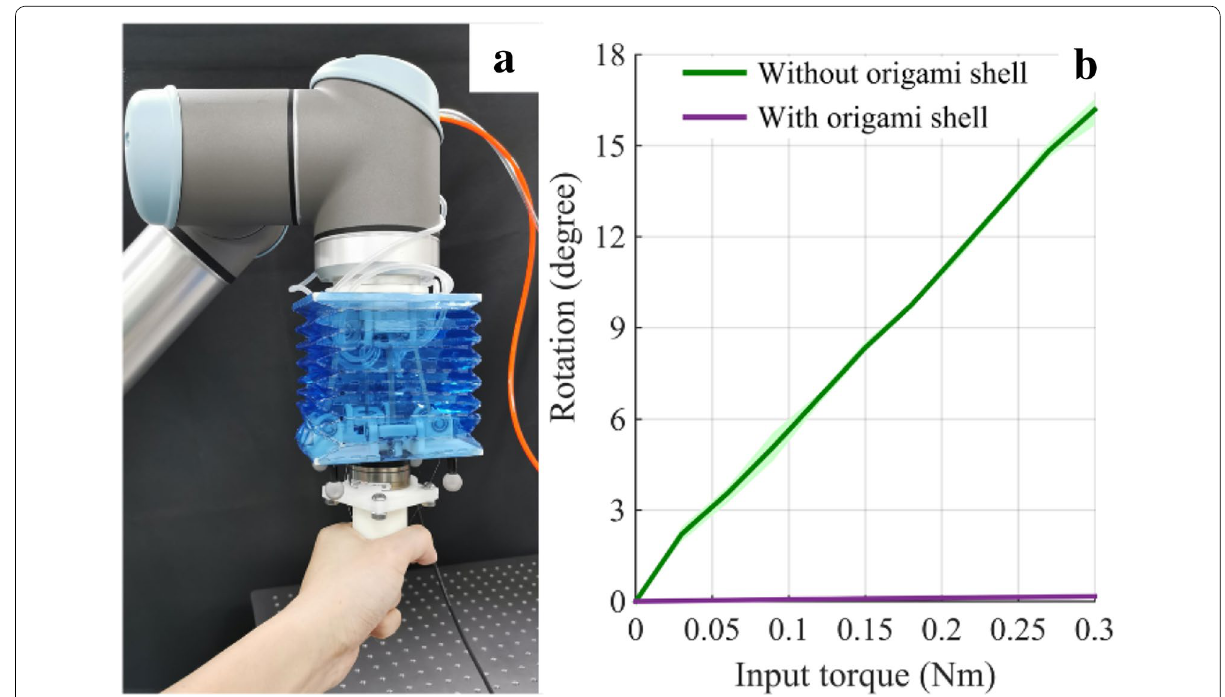
Figure 12 Experiment and results of the torsional strength tests with/without the origami